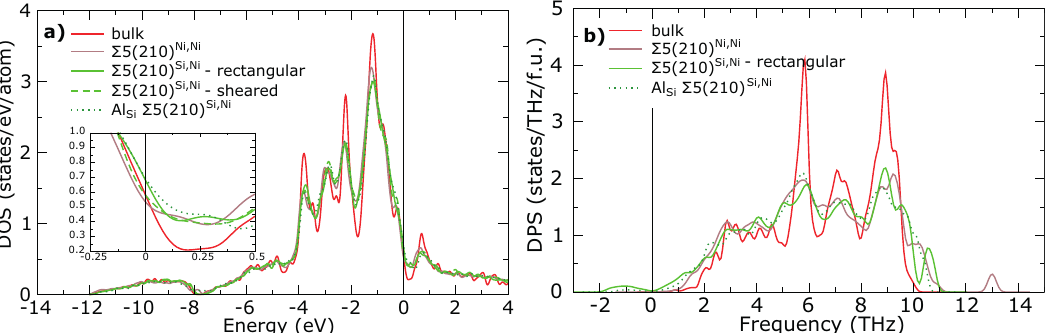
Figure 4. ( a ) Total density of states (DOS) per atom for all studied GBs and bulk Ni 3 Si. The inset figure shows the DOS around the Fermi level, E F , which is set to be the energy zero. ( b ) Total density of phonon states (DPS) per formula unit for all undistorted GBs and bulk Ni 3 Si (see also the phonon spectra in the Appendix A).